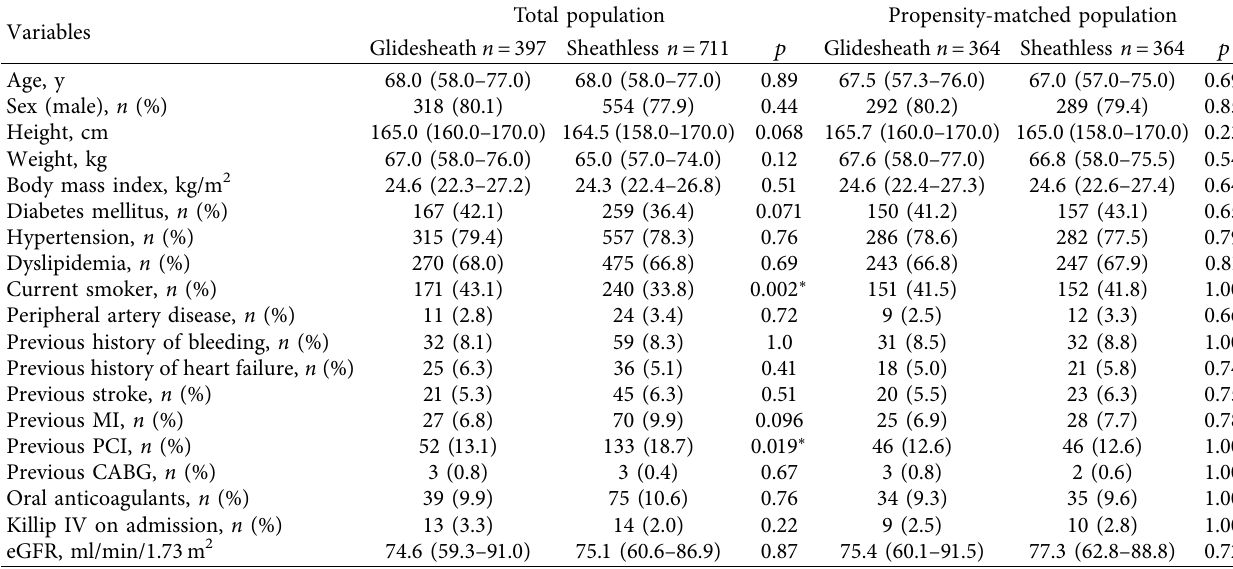
Table 1: Baseline clinical characteristics of the study